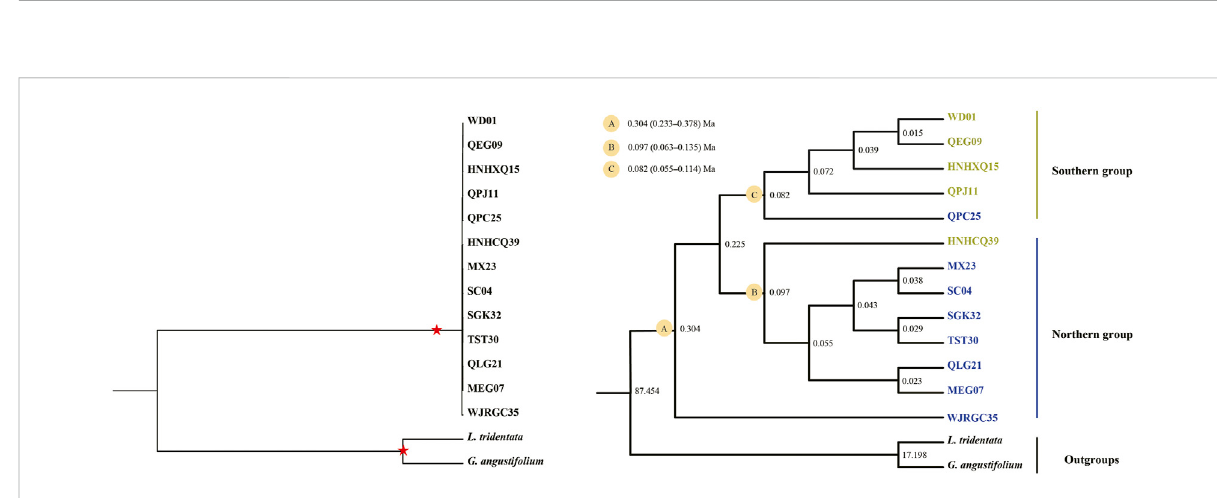
FIGURE 8 The BEAST-derived chronograms of T. mongolica with two calibration points. The divergence time estimates based on the complete cp genome sequences. Red pentastar represented the calibration